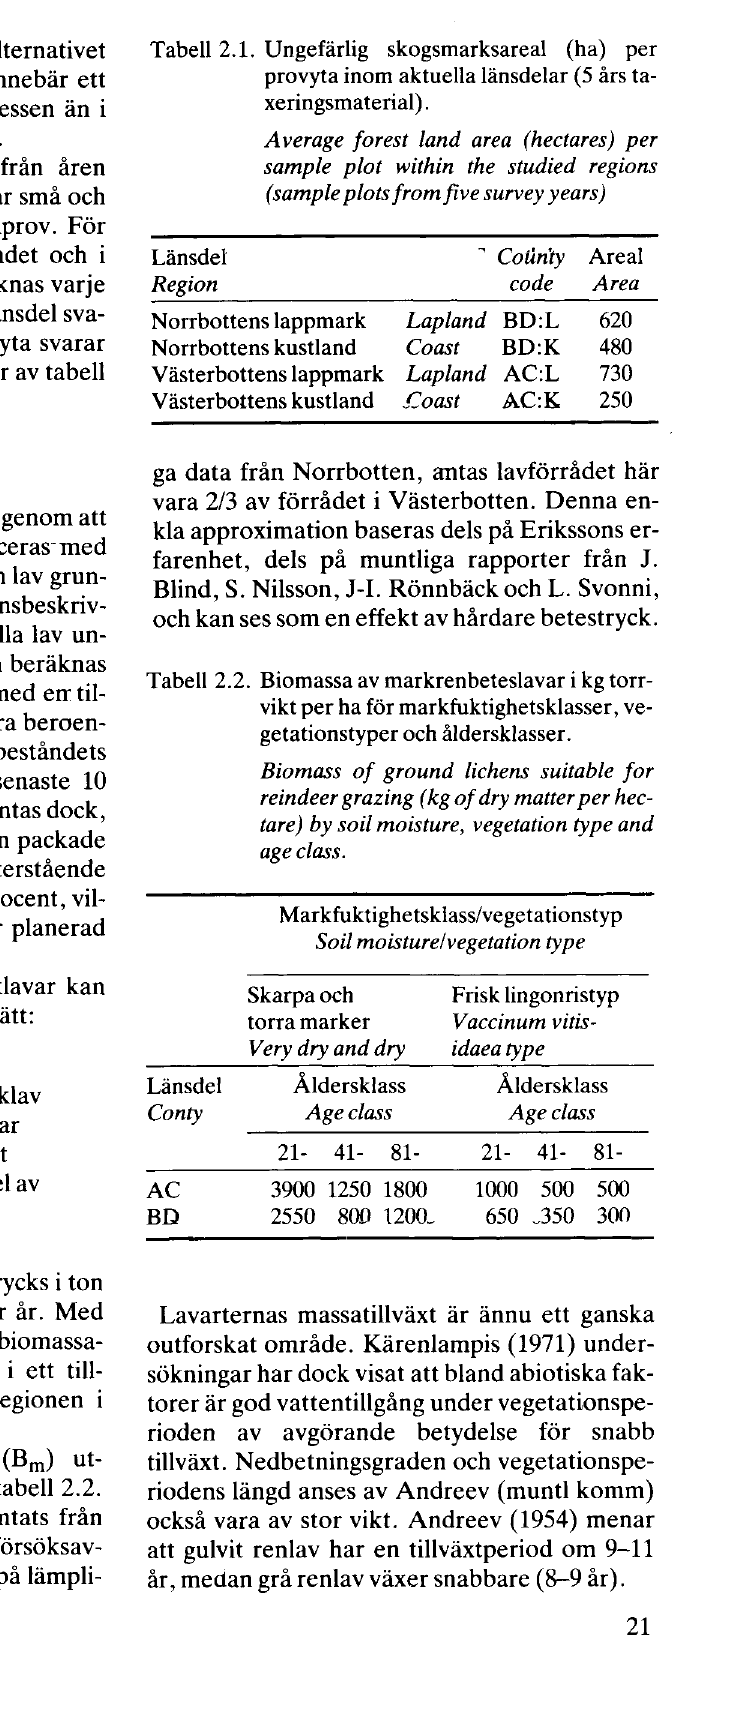
Tabell 2.1. Ungefårlig skogsmarksareal (ha) per provyta inom aktuella lånsdelar (5 års ta¬ xeringsmaterial).